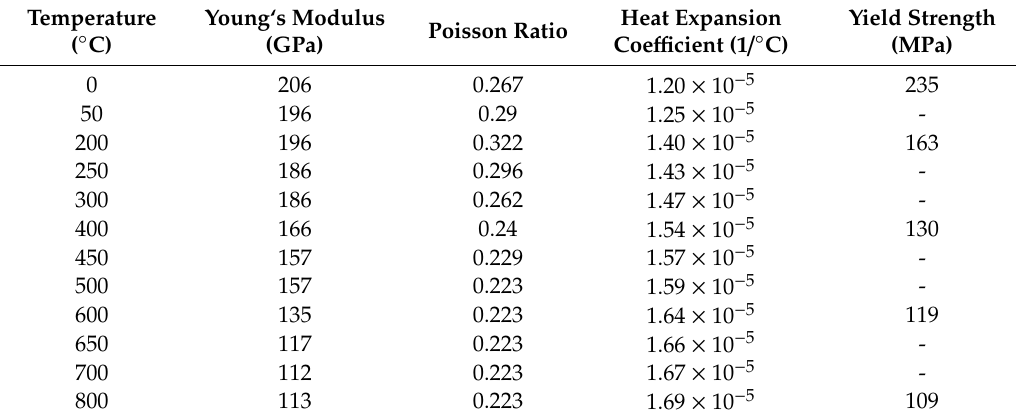
Table 2. Mechanical parameters of low carbon steel.